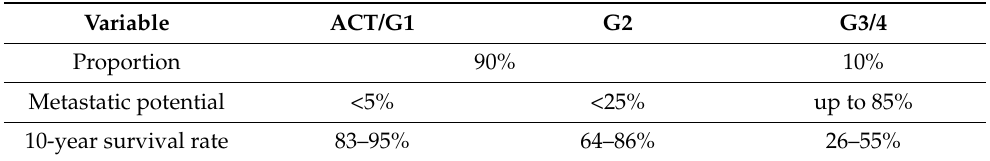
Table 3. Prevalence, metastatic potential, and 10-year survival rate according to the tumor grading. (Abbreviation: ACT, atypical cartilaginous tumor). Variable ACT/G1